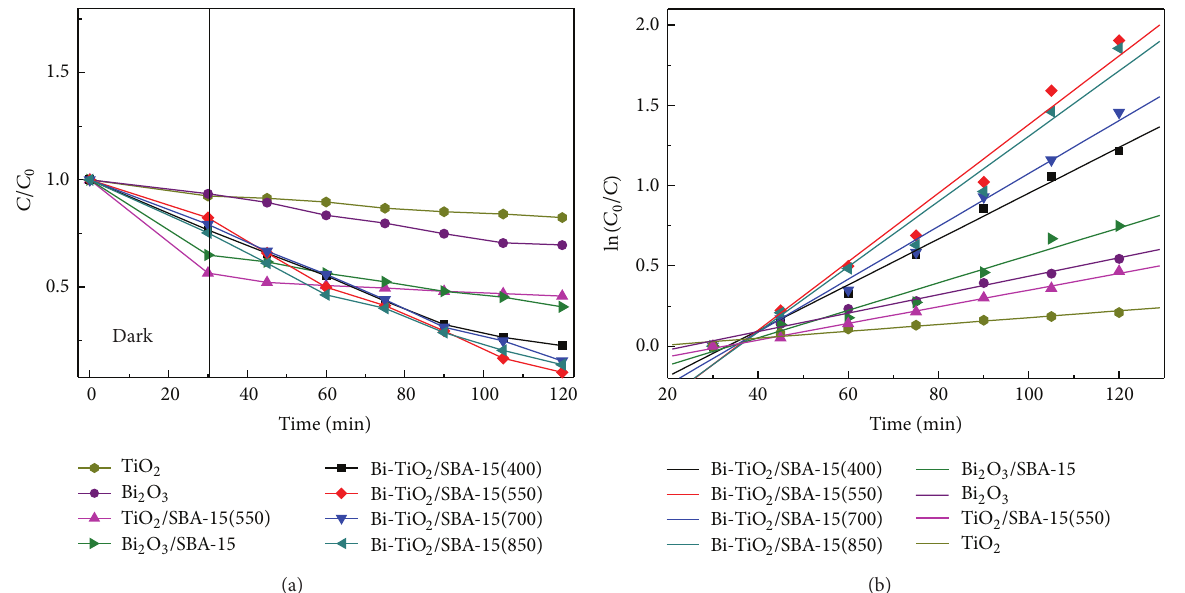
Figure 6: Photocatalytic activity (a) and kinetic linear simulation curve (b) of photocatalytic degradation by Bi-TiO 2 /SBA-15( x ) under visible light.